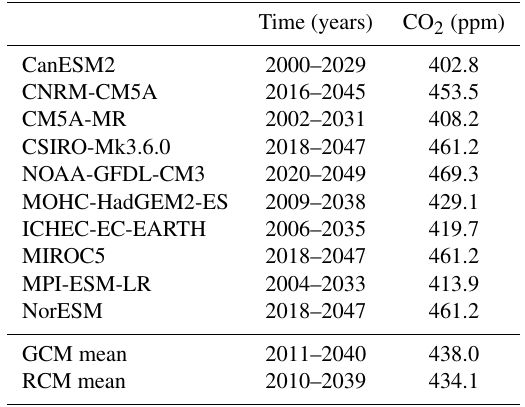
Table 2. GCM time slices at + 1.5K and their corresponding carbon dioxide